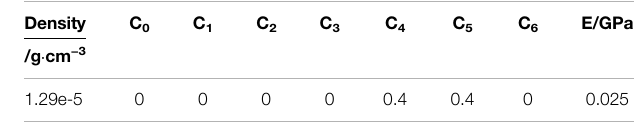
TABLE 4 | Air material and its state equation